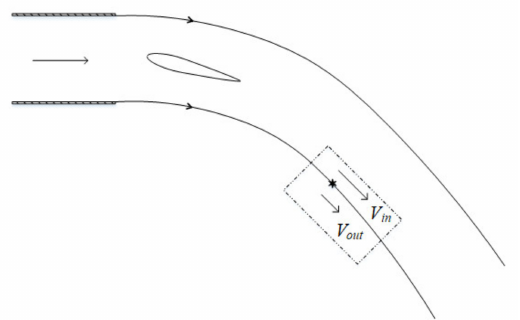
Figure 4. The deflection of the jet